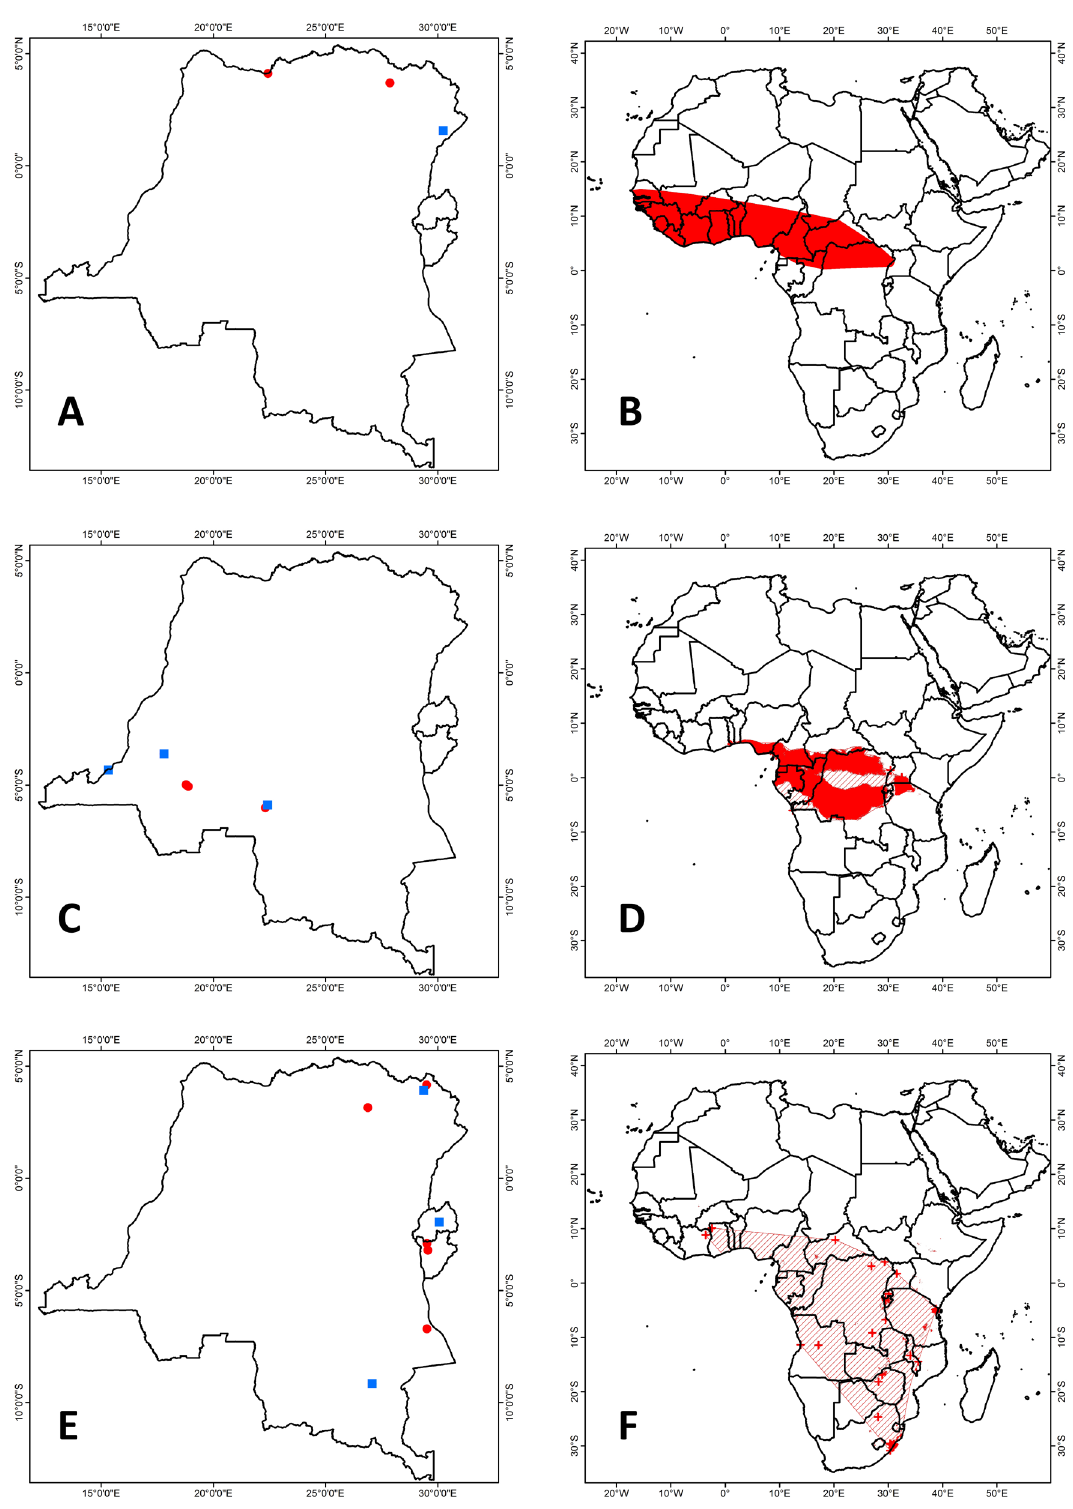
Fig. 31. Distribution maps. A–B . Myopterus daubentonii Desmarest, 1820. C–D . Myopterus whitleyi (Scharff, 1900). E–F . Otomops martiensseni (Matschie, 1897). A, C, E. Distribution in the CRB area. B, D, F.